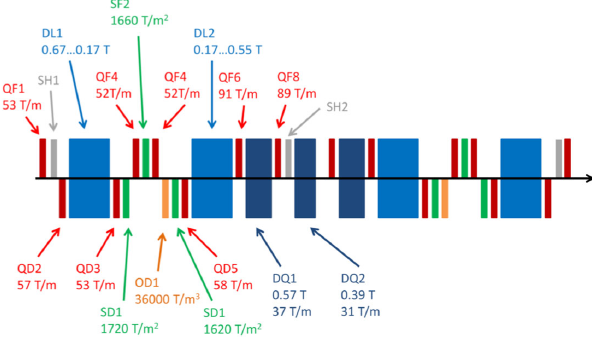
FIG. 2. Simplified view of the lattice magnets of a standard cell of the ESRF-EBS [7]. QD and QF are quadrupoles, DQ are dipole-quadrupoles, DL are dipoles, SD and SF are sextupoles, OD are octupoles, and SH are (sextupole-like) dipole and skew quadrupole correctors.